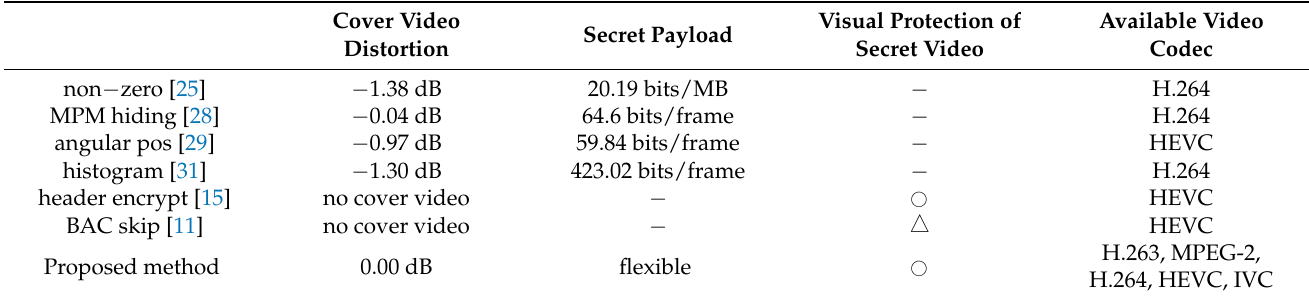
Table 6. Feature compare with conventional methods.